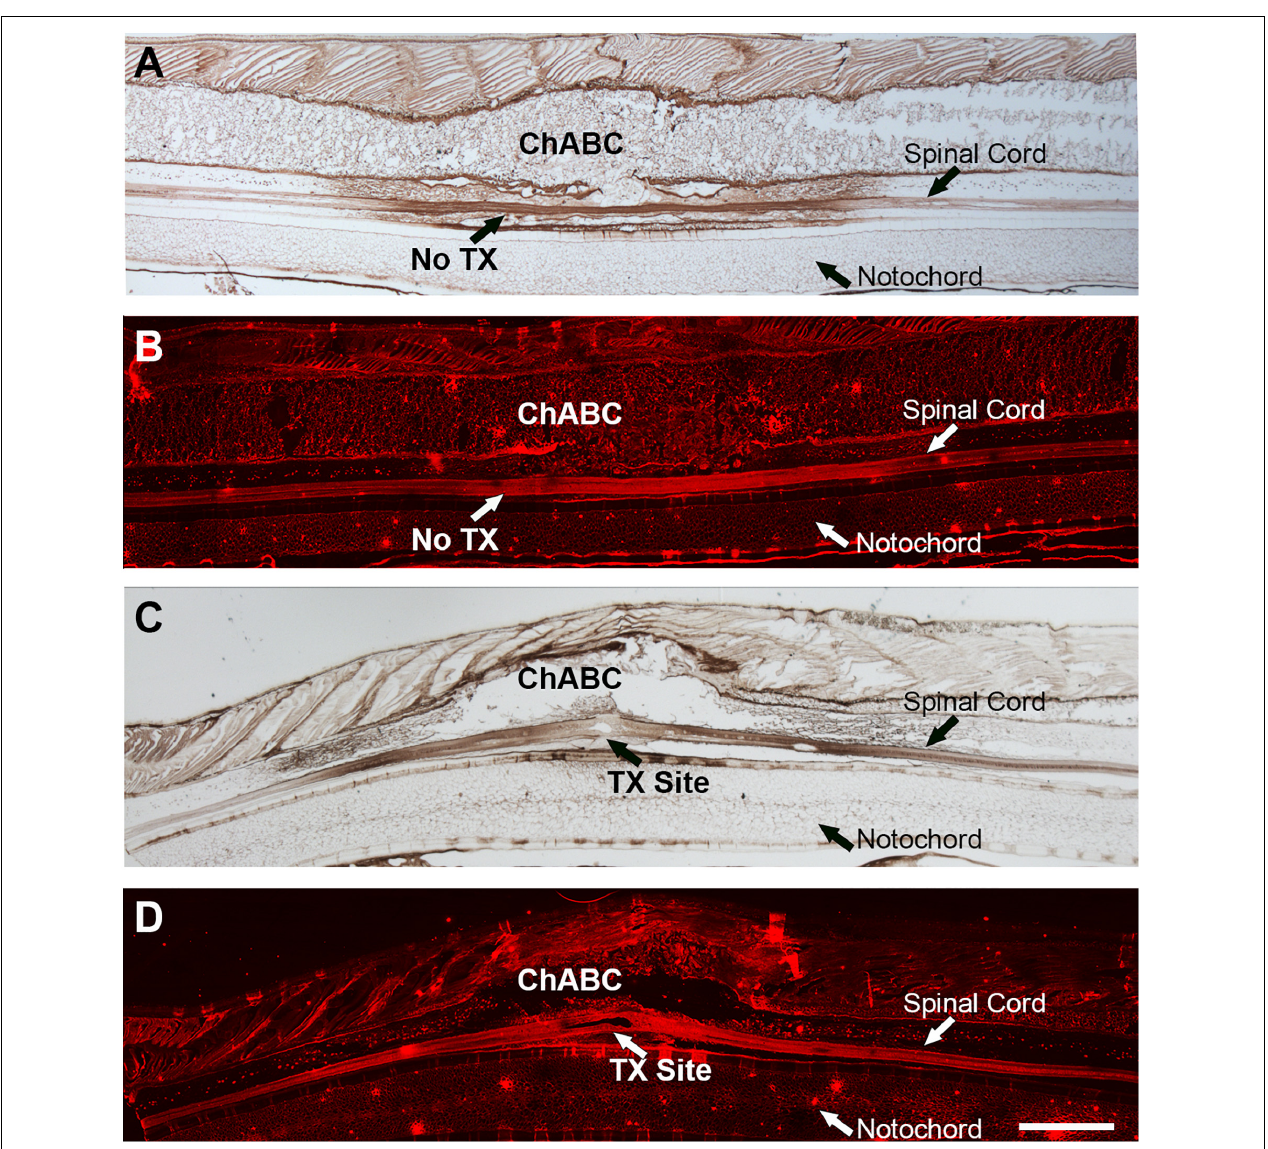
FIGURE 1 | ChABC treatment of lamprey spinal cord after transection. Stumps of digested CSPGs were labeled with mAb 2B6 and imaged in sagittal sections of spinal cord by colorimetric immunohistochemistry (A,C) or Alexa Fluor-594 immunofluorescence (B,D) . A , B are intact lamprey spinal cord treated with ChABC. C,D are sections of a spinal cord that had been transected and treated with ChABC 2 weeks previously. Scale: 1 mm.